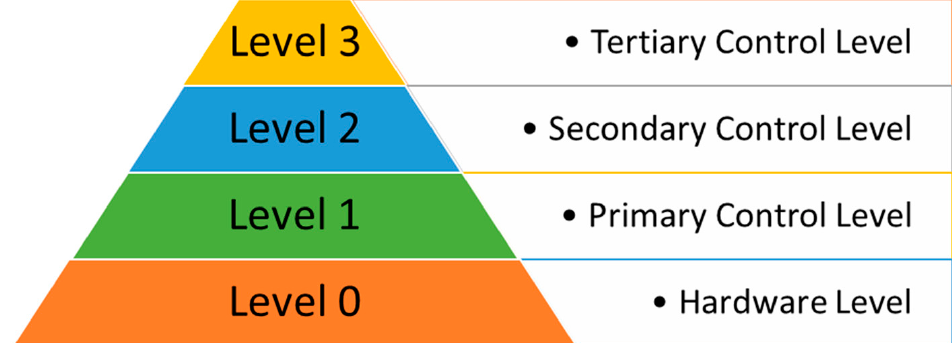
Figure 2. Representation of the microgrid hierarchical architecture.